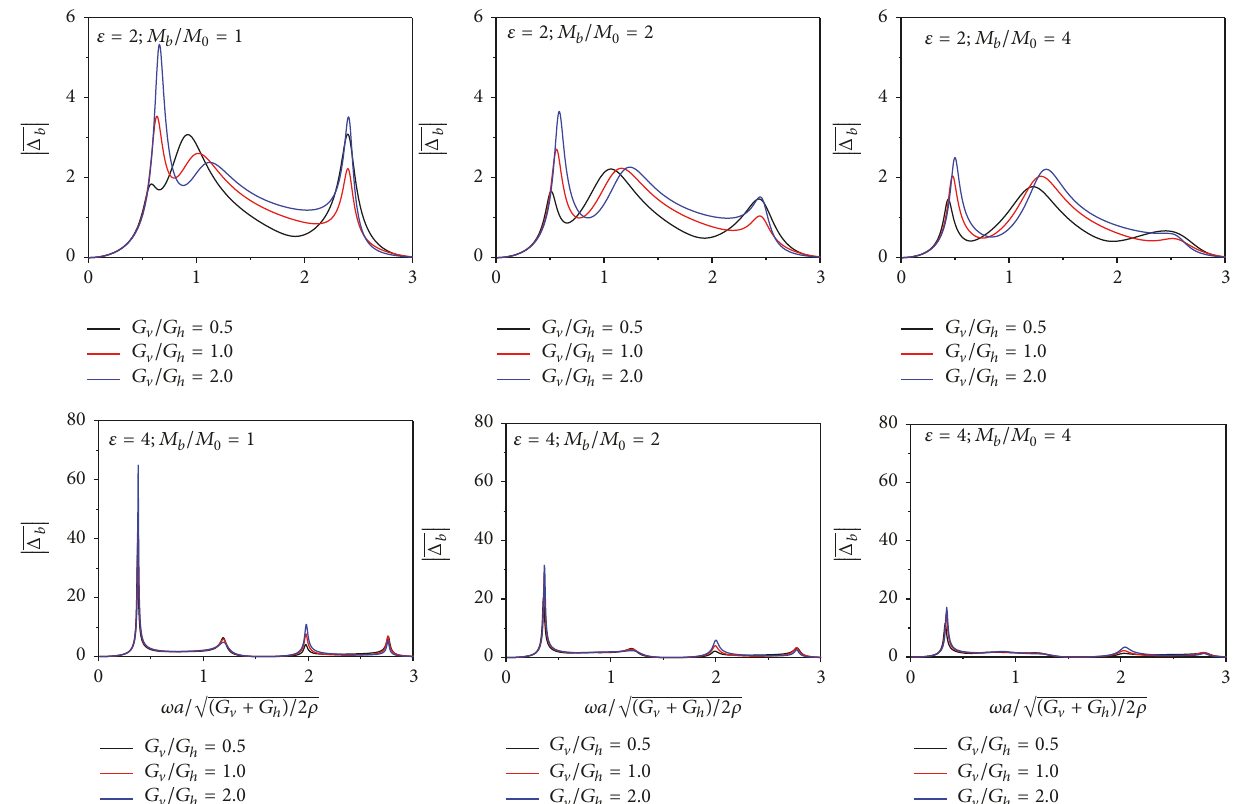
Figure 6: The superstructure response for different flexibility and mass of superstructure and for 𝐷/𝑎 = 2 .